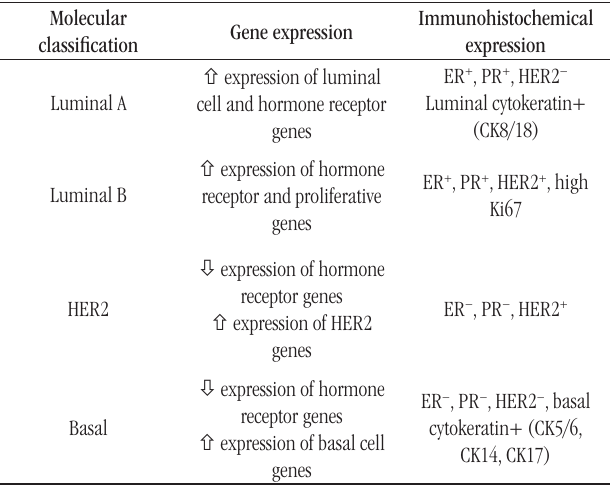
taBLE 1 − Correlation between immunohistochemical analysis and gene expression for molecular